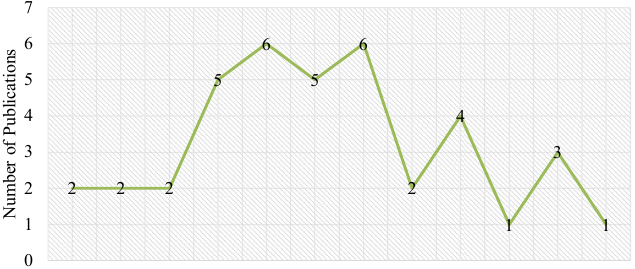
Figure 1. Yearly publications